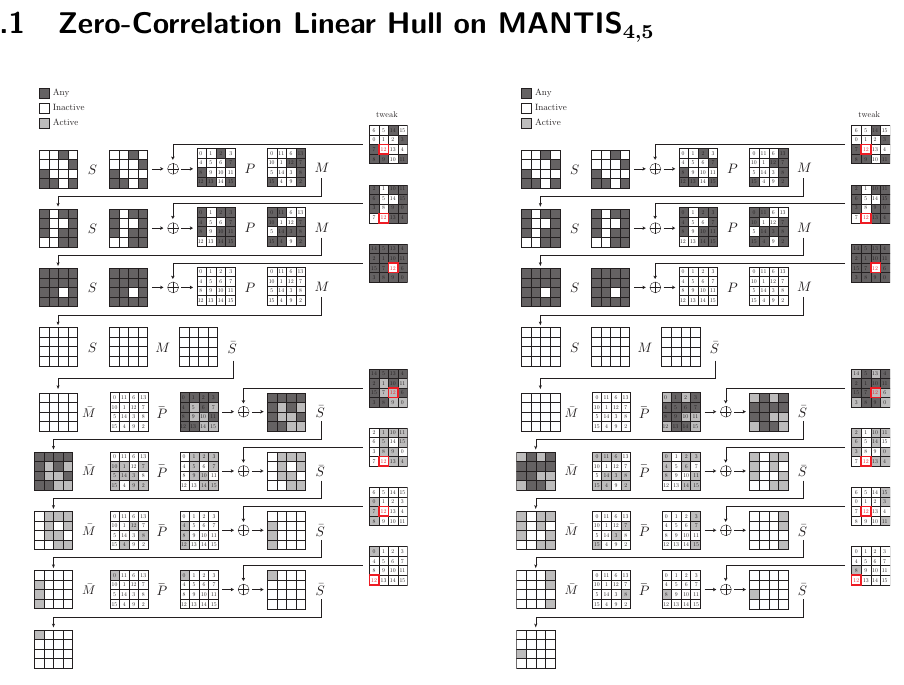
Figure 24: Two zero-correlation linear hulls on Mantis 4 , 5